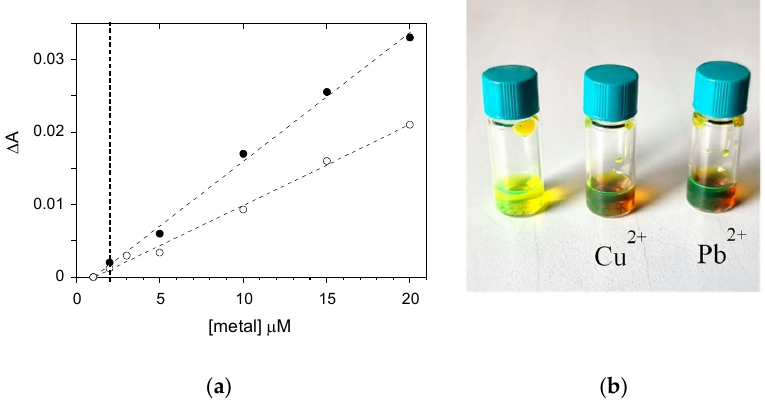
Figure 5. ( a ) Variation in the absorbance ∆ A of a 30 µ M PTAS water solution, measured at 490 nm, as a function of the metal ion concentration for Cu 2+ (open circles) and Pb 2+ (solid circles). The best linear fits are shown as dashed lines, the detection limit of 2 µ M can be identified with the vertical bold dashed line. ( b ) Pictures of the PTAS water solution before (left) and after addition of 30 µ M metal ions (right).